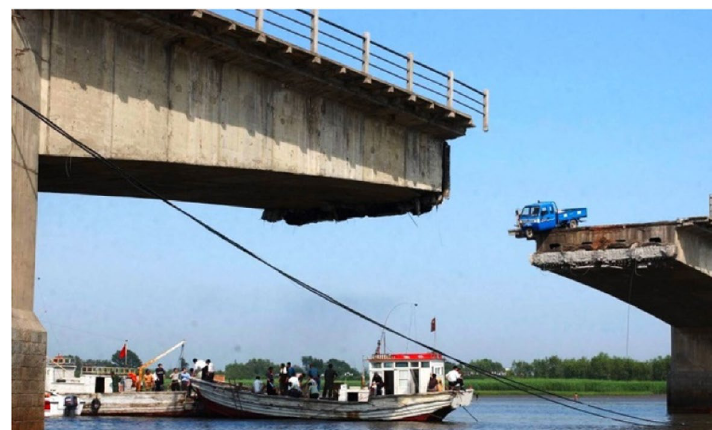
Fig. 5 The Tianzhuangtai Bridge in Liaoning Province